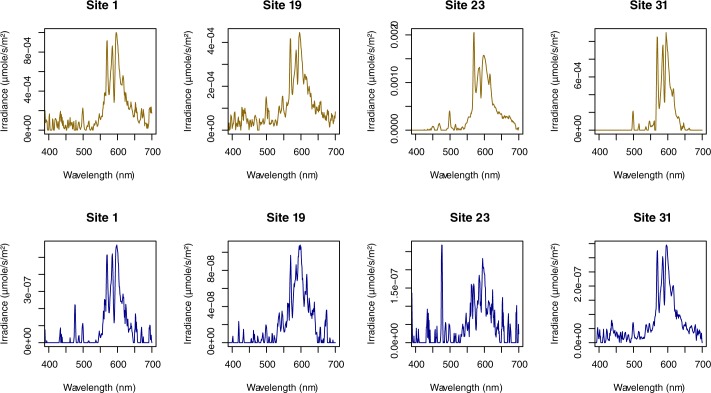
Spectral downward irradiance above water (brown) and below 1 m (blue) in 4 urban and periurban ponds.Irradiance (μmole/s/m2) was measured in the 300–700 nm range under an overcast sky conditions.